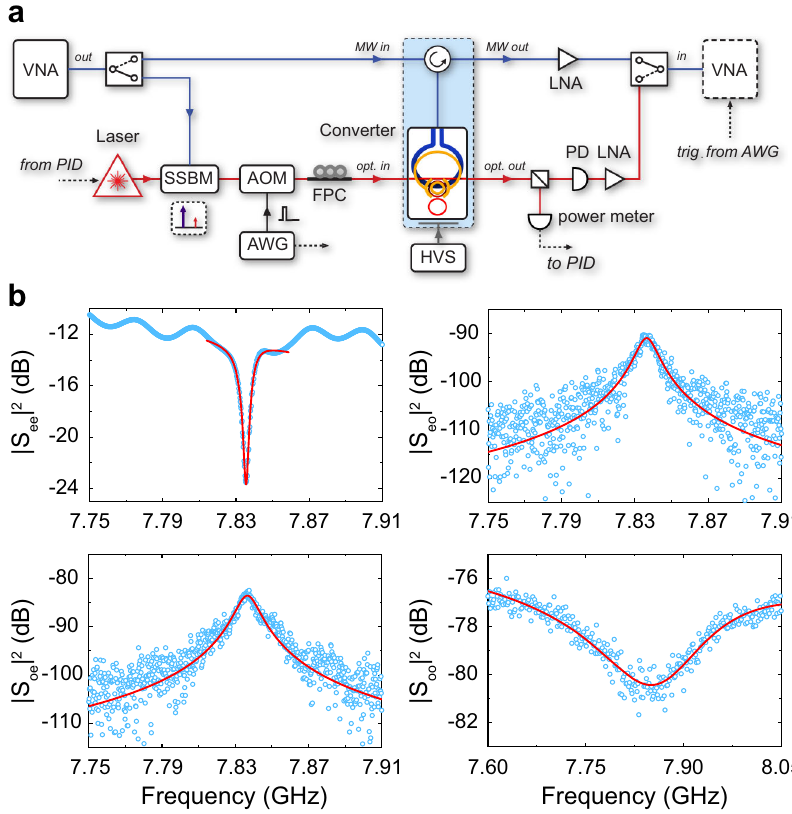
Fig. 3 Bidirectional conversion. a Measurement setup. The output of a vector network analyzer (VNA) is sent to the device either as the microwave input or as the optical input through a single-sideband modulator (SSBM). For quasi-CW measurements, the optical pump is gated by an acoustic-optic modulator (AOM) driven by an arbitrary wave generator (AWG), which also triggers the VNA. The pump is locked to the optical cavity with a PID controller. FPC: fi ber polarization controller. PD: photodetector. LNA: low-noise ampli fi er. HVS: high voltage source. b Measured microwave re fl ection S ee , optical-to-microwave conversion S eo , microwave-to-optical conversion S oe and optical re fl ection S oo . The peak optical pump power is − 12.0 dBm in the waveguide and all matrix coef fi cients are normalized to the VNA